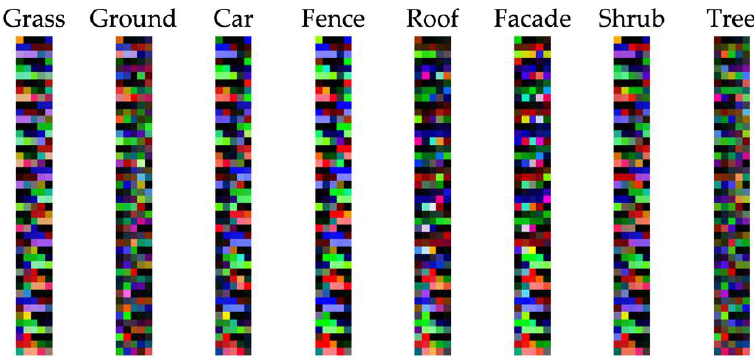
Figure 7. Generated 3D patches (transposed for better picturing) based on the ISPRS Vaihingen dataset classes.